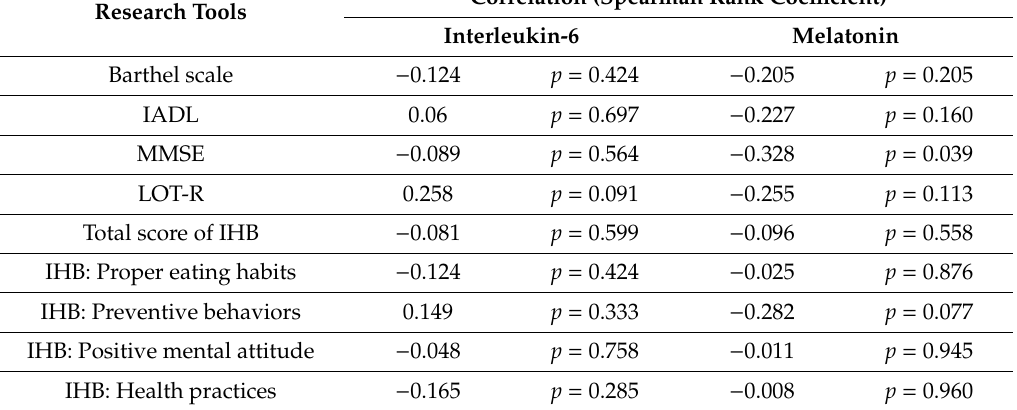
Table 6. The relationship between the level of interleukin-6 and melatonin and the results obtained from standardized research tools among respondents aged 60–75 belonging to the comparative group (n =